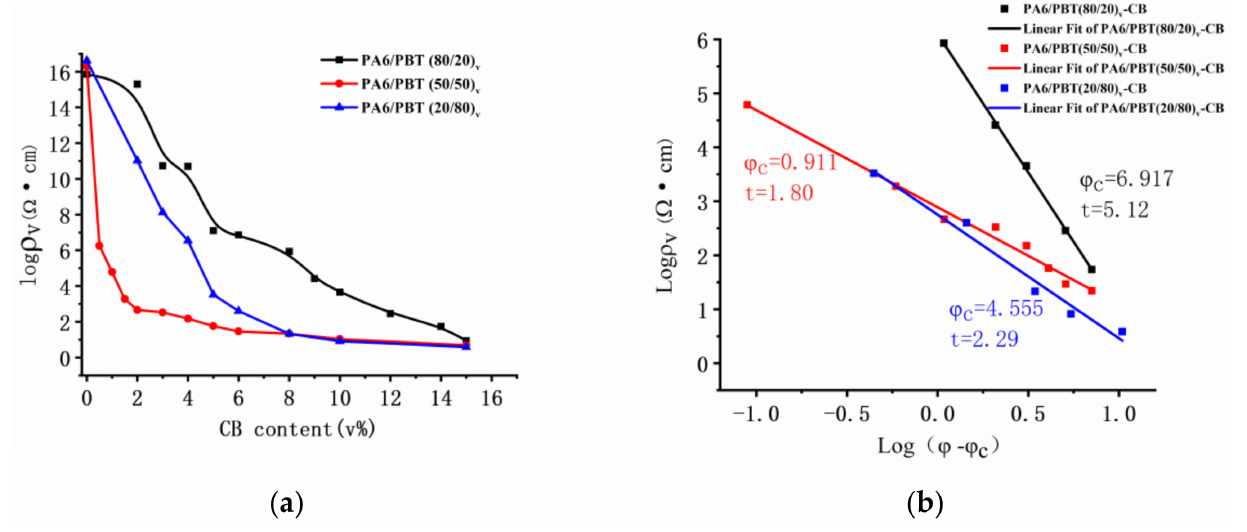
Figure 1. Electrical resistivity as a function of CB content ( a ), a log–log plot of electrical resistivity versus ( ϕ − ϕ c ) ( b